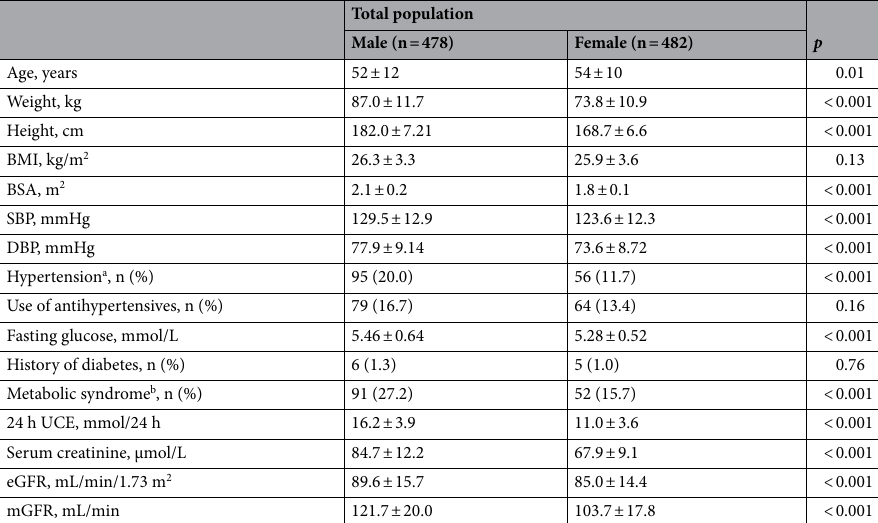
Table 1. Baseline characteristics of the study population. Values of variables are given as mean ± standard deviation or number (percentage). Statistical significance is displayed for male vs female. BMI body mass index (kg/m 2 ), BSA body surface area (m 2 ), SBP systolic blood pressure (mmHg), DBP diastolic blood